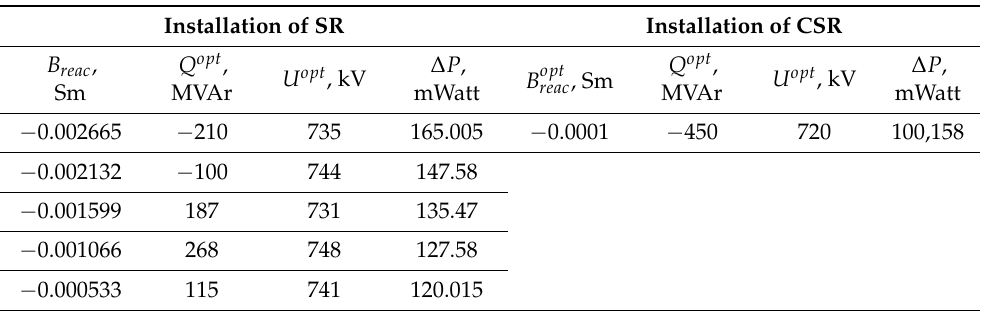
Table 9. Results of parametric optimization when using CSR and SR for bulk electrical power network with ideal transposed extra-high voltage power lines.